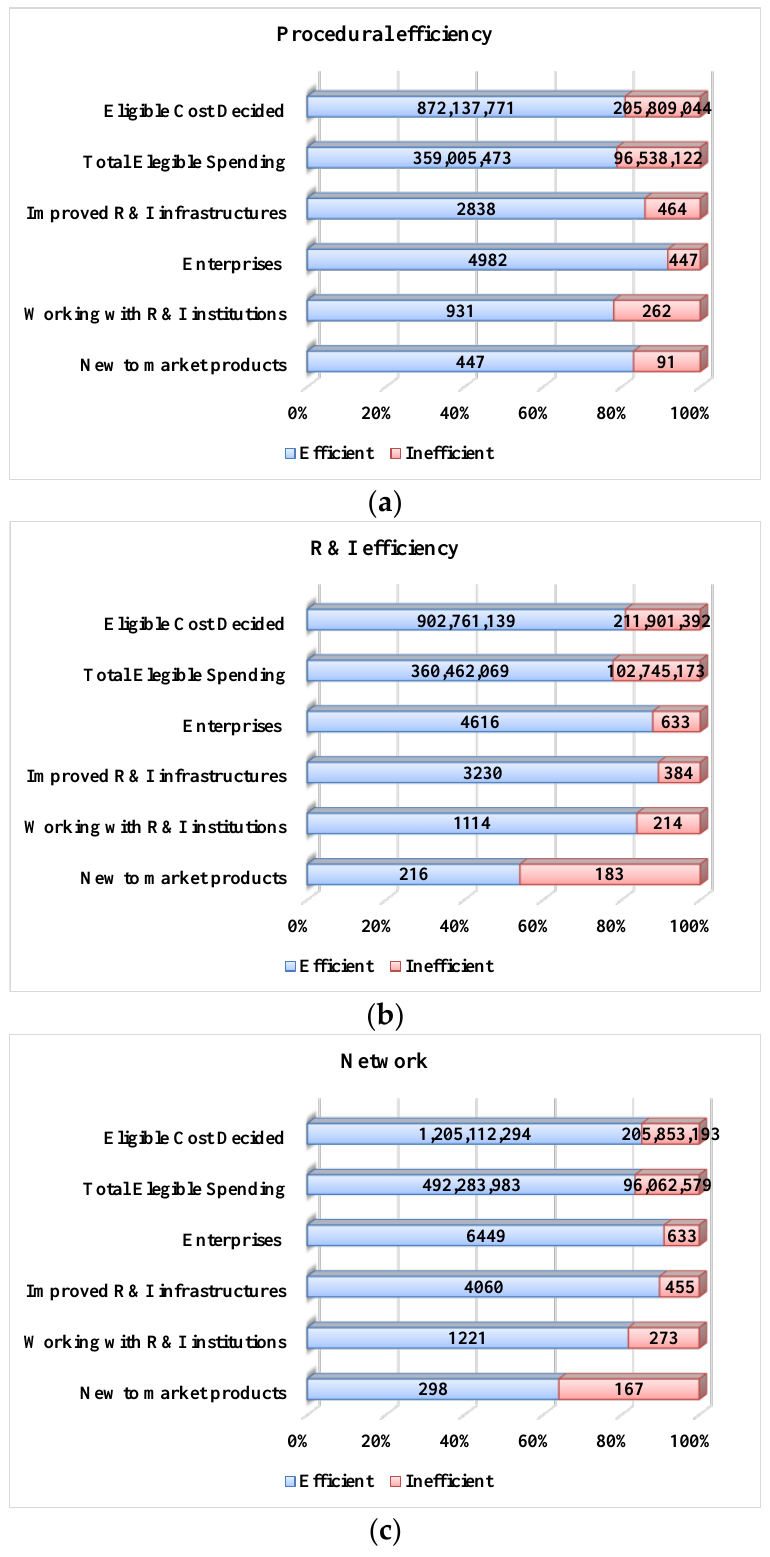
Figure 4. Average input and output values for the efficient and inefficient OPs according to the cluster-frontier for Procedural efficiency ( a ), R&I potential capacity ( b ), and overall network efficiency ( c ).